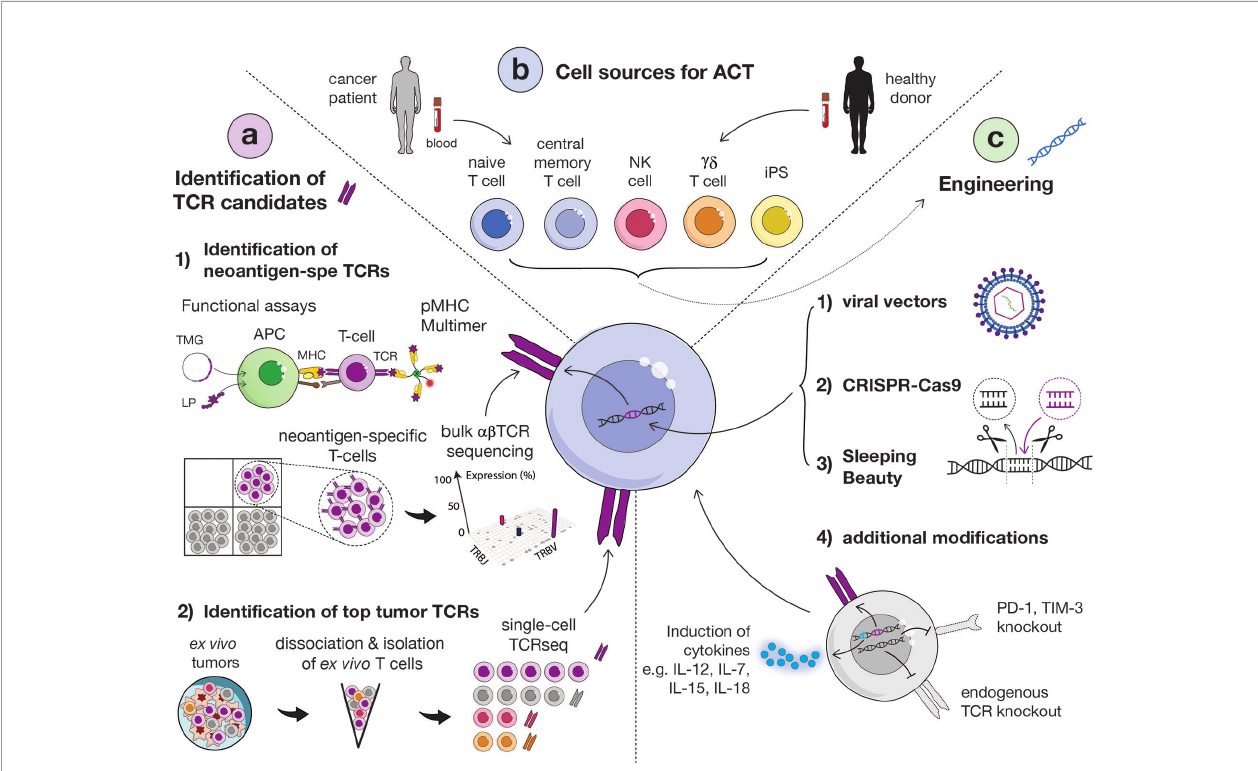
FIGURE 2 | Overview of main strategies to identify relevant TCRs, methods for transduction and options of carrier cells. (A) Identi fi cation of TCR candidates via functional assays and sequential isolation of neoantigen-speci fi c T cells based on pMHC multimer staining. Isolated neoantigen-reactive T cells can then be sequenced in bulk for the identi fi cation of dominant TCR clonotypes (1). Alternatively, tumor-speci fi c TCRs can be identi fi ed directly from ex vivo fresh tumor, without intermediate culture, by sorting T cells by fl ow cytometry and performing single-cell TCR sequencing (2). (APC, antigen presenting cell; MHC, major histocompatibility complex; LP, long peptide; TMG, tandem minigene). (B) Several carrier cells can be used for TCR transduction, including ab (CD4 or CD8) T cells, naïve or central memory cells, NK cells, gd T cells and induced-pluripotent stem cells (iPSCs). Carrier cells can be derived from healthy donor or patient blood. (C) TCR engineering into carrier cells can be obtained via viral (1) or non-viral vectors [such as CRISPR-Cas9 (2) or Sleeping Beauty (3)]. Additional modi fi cations of cells to enhance their functionality and in vivo persistency but also avoid TCR mispairing can be performed, such as the knock-out of endogenous TCR or immune inhibitor genes and the induction of cytokines